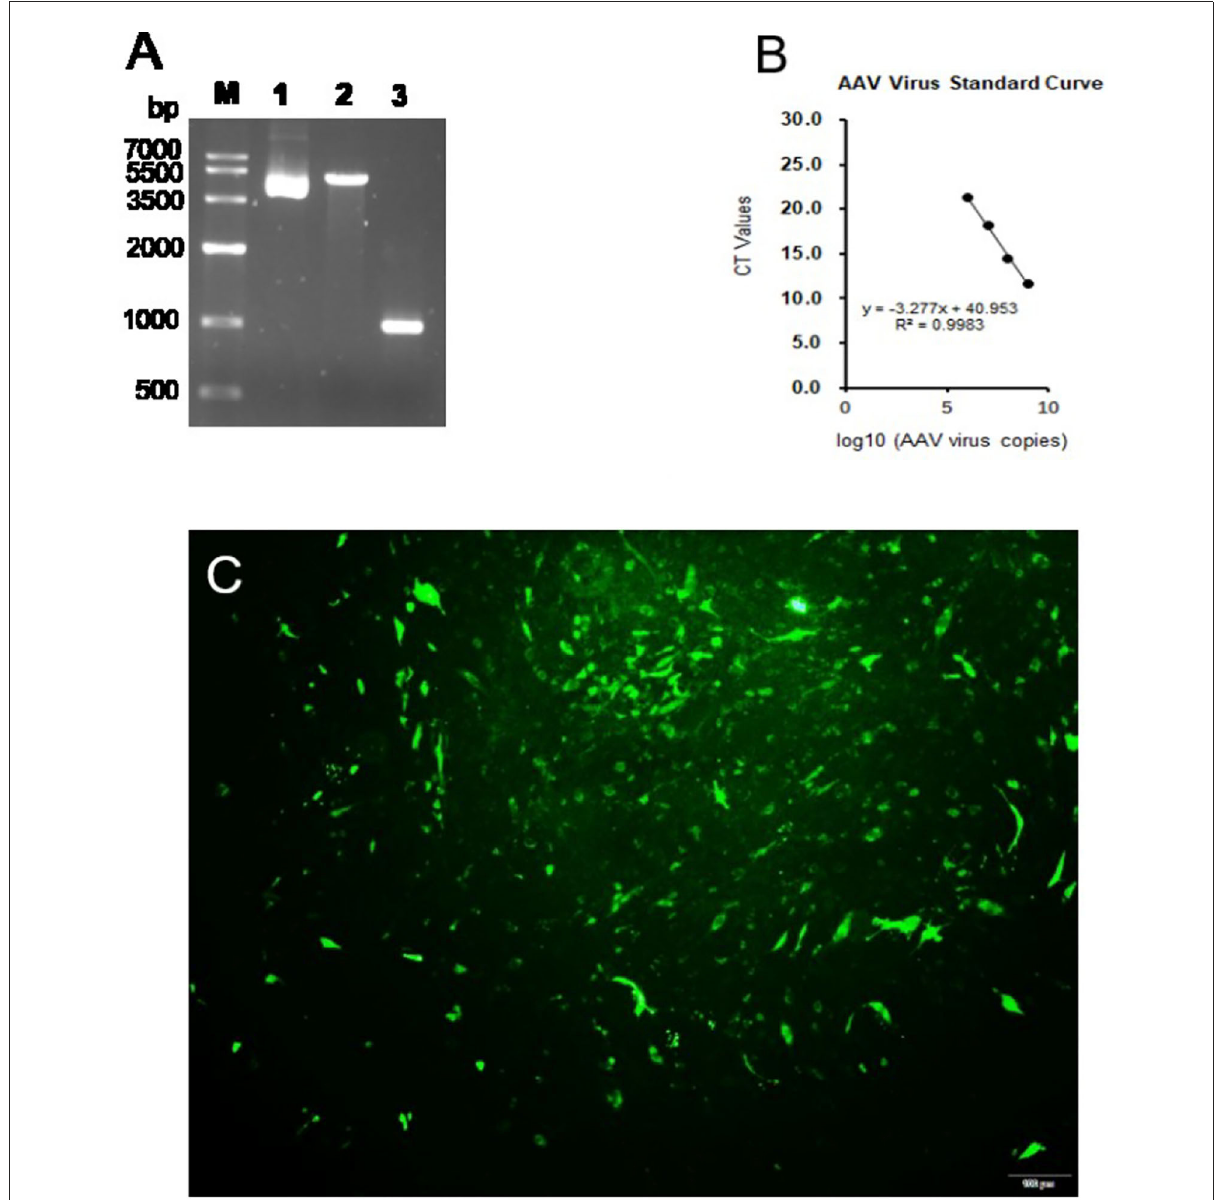
FIGURE2 pAAV-GPR41 vector construction and virus. (A) Lane 1, pAAV expression plasmid vector. Lane 2, pAAV vector linearized by EcoRI and BamHI. Lane 3, GPR41 amplification by pAAV-GPR41 as template. (B) Standard curve of AAV virus. (C) Bovine hepatocytes infected by the pAAV-GFP